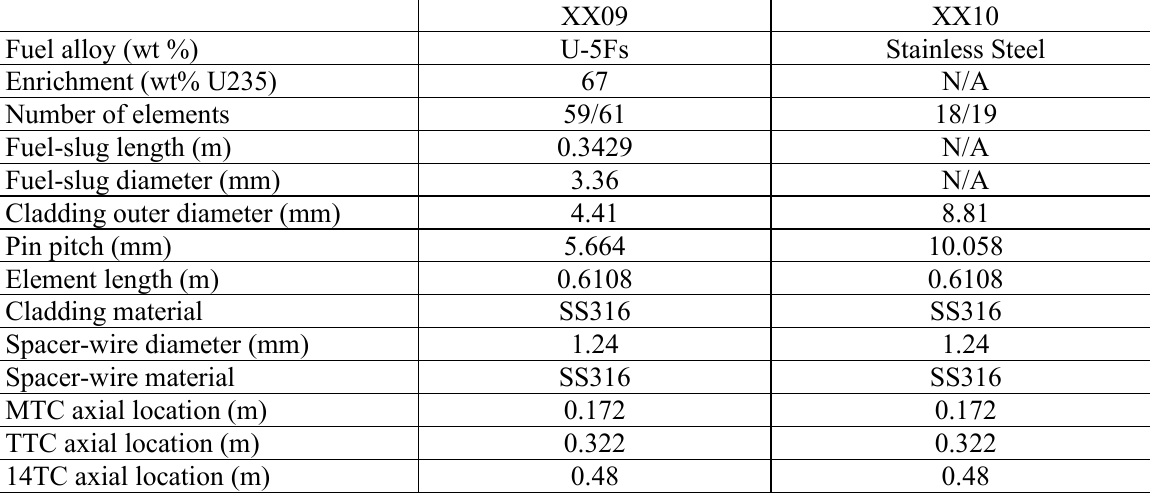
Figure 1. Instrumented subassembly XX09 (left), XX10 (right); FM (flow meter), MTC Midcore cladding TC, TTC Top of core cladding TC, 14 TC Above core TC [10] Table I. Design parameters of the instrumented subassemblies XX09 and